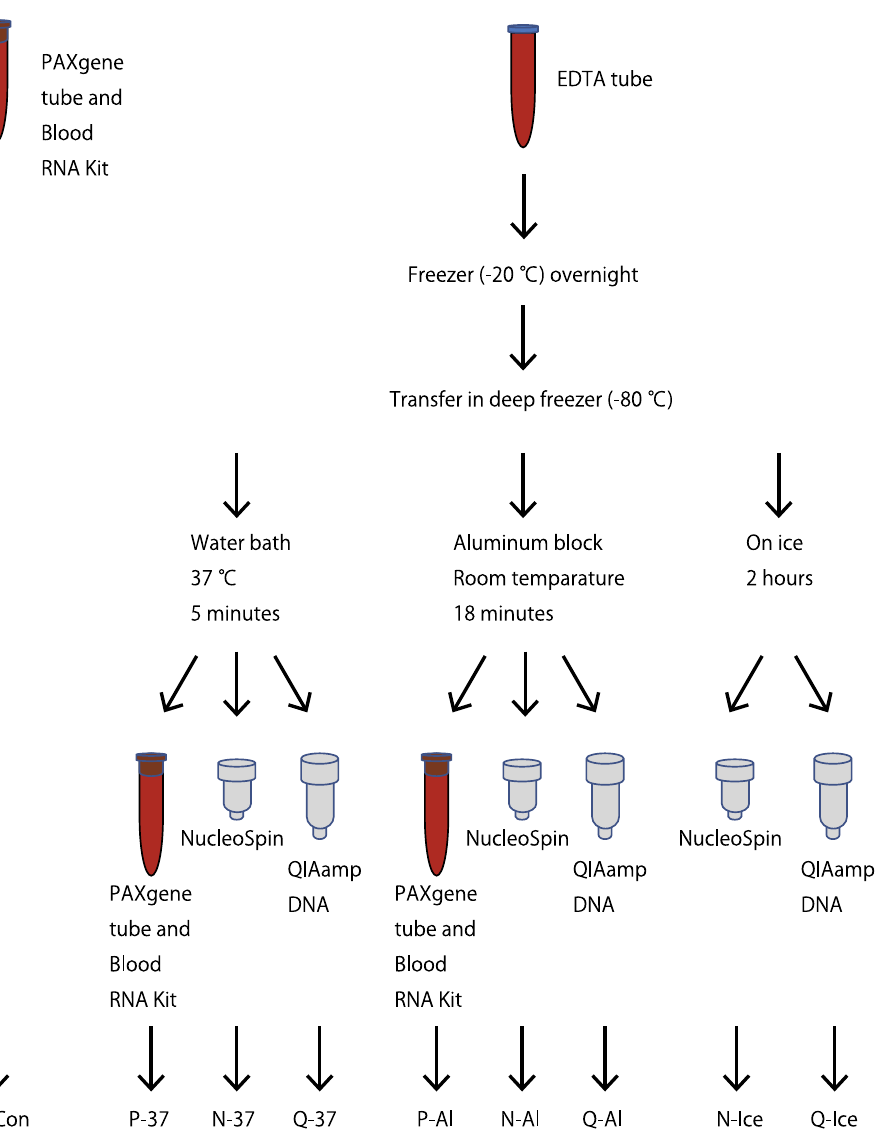
Figure 1. Workflow of RNA and DNA purification in this study. RNA quality and yield under the following six conditions: P-Con, fresh blood and PAXgene kit; P-37, frozen blood thawed using a 37 °C water bath and PAXgene kit; P-Al, thawed using aluminum blocks and PAXgene kit; N-37, thawed using a 37 °C water bath and NucleoSpin kit; N-Al, thawed using aluminum blocks and NucleoSpin kit; and N-Ice, thawed on ice and NucleoSpin kit. DNA yield under the following three thawing conditions using the QIAamp DNA blood kit: Q-37, thawed using a 37 °C water bath; Q-Al, thawed using aluminum blocks; Q-Ice, thawed on ice. The images were created using Microsoft PowerPoint 2016 MSO (16.0.14131.20278) 32 bit (https:// www. micro soft. com/) and Adobe Illustrator CS5 (https:// www. adobe.